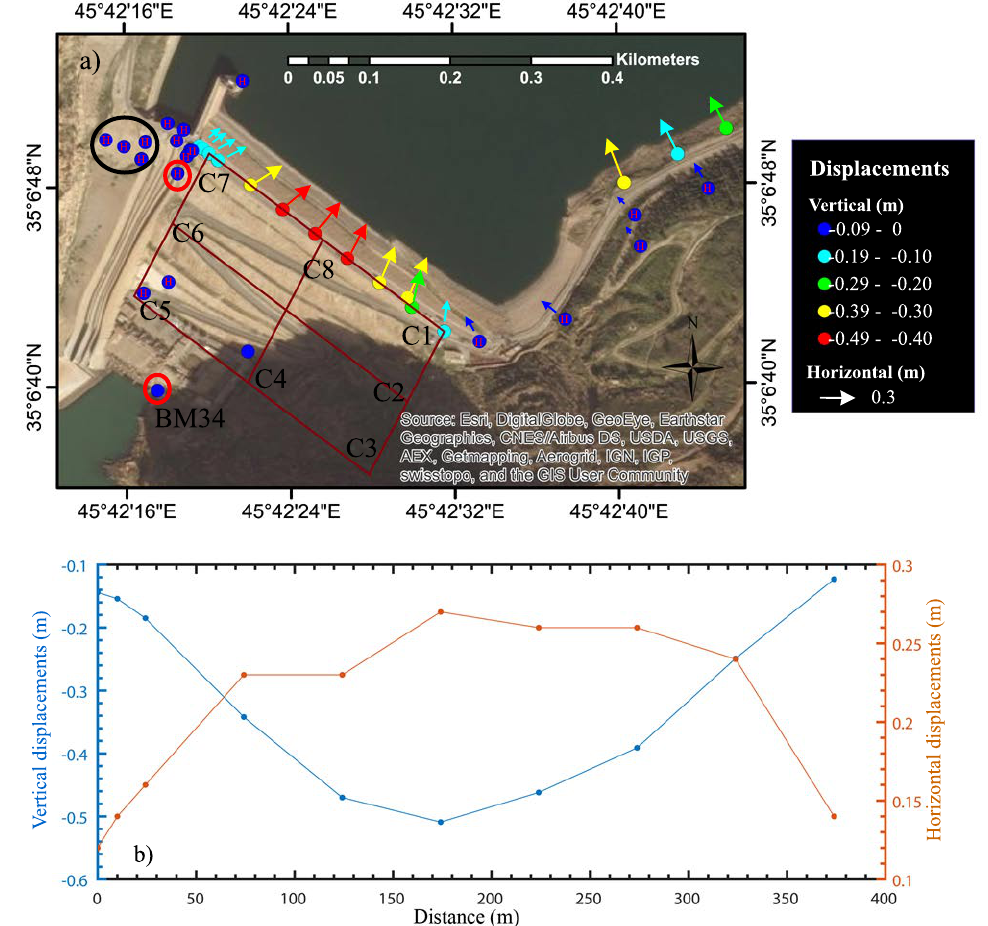
Figure 7. The relative vertical and horizontal co-seismic displacements inferred from levelling and GPS measurements collected in March and November 2017. The source of the background image from [5] ( a ) arrows indicate the direction and magnitude of the horizontal displacements, and different colours of circles represent different magnitudes of the vertical displacements. The red lines labelled with C1–C8 refer to the displacement cross-sections in Figure 9. ( b ) The cross-section of C7–C1 for both the vertical and horizontal